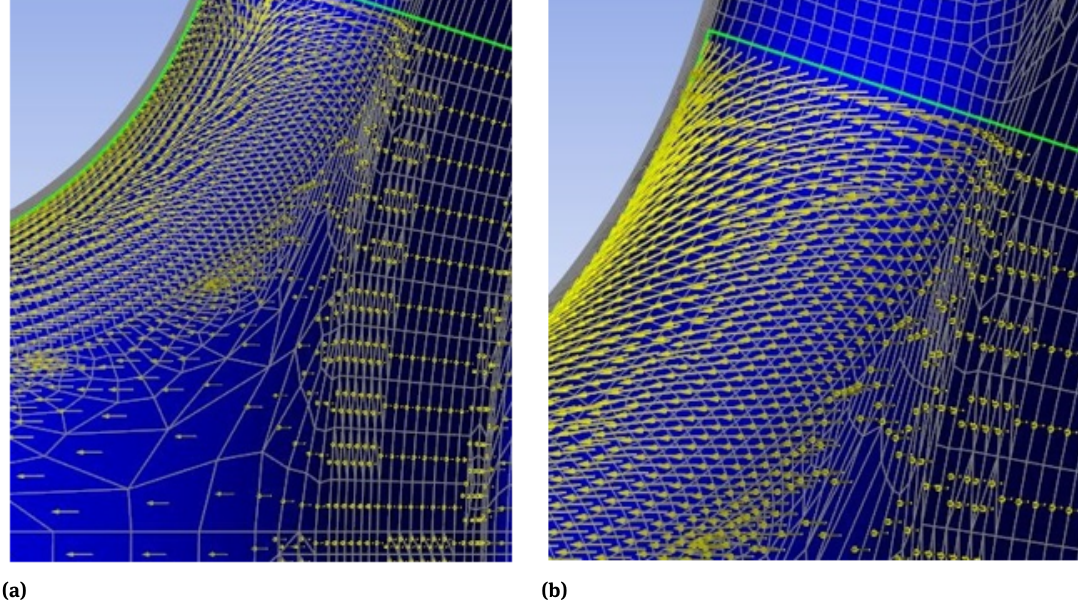
Figure 6: (a) Fibre reference direction of a ply before draping; (b) fibre reference direction after